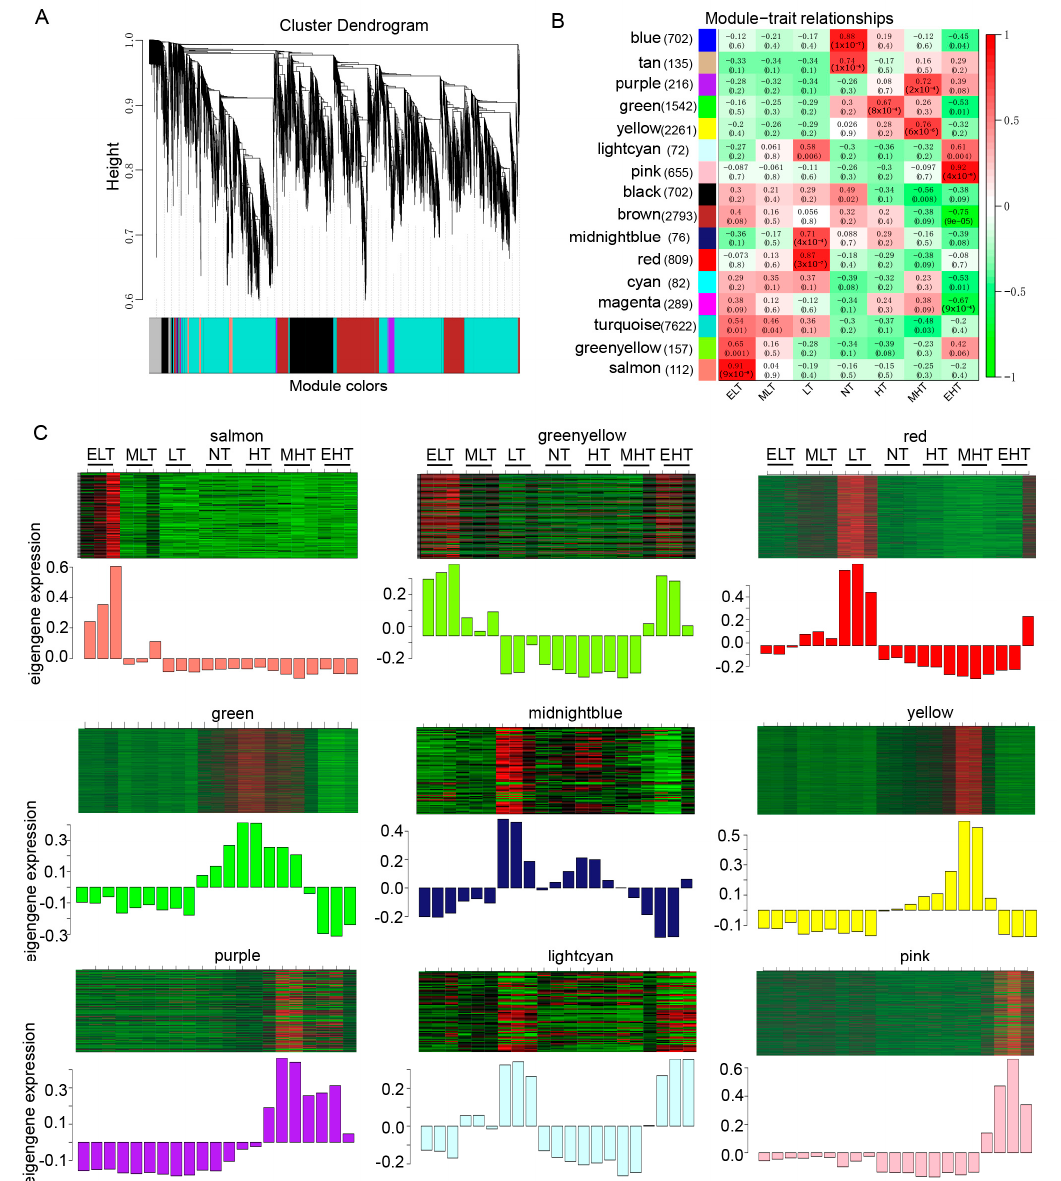
Figure 7. Co-expression network analysis of transcripts involved in temperature stress (TS) in maize seedling leaves. ( A ) The weighted gene co-expression network (WGCNA) identified 16 modules presented by hierarchical cluster tree and color bands. ( B ) Analysis of the module–trait association. Each row represents a module, and each column represents a sample under TS conditions. The numbers on the top and bottom of each cell represent the correlation and significant p-values, respectively. The number of genes in each module is presented in the bracket. ( C ) Heatmap indicating the eigengene expression profile for nine significantly associated modules in ELT, MLT, LT, NT, HT, MHT, and EHT. ELT, extreme low temperature, 4 °C; MLT, medium low temperature, 10 °C; LT, low temperature, 16 °C; NT, normal temperature, 25 °C; HT, high temperature, 37 °C; MHT, medium high temperature, 42 °C; and EHT, extreme high temperature, 48 °C.